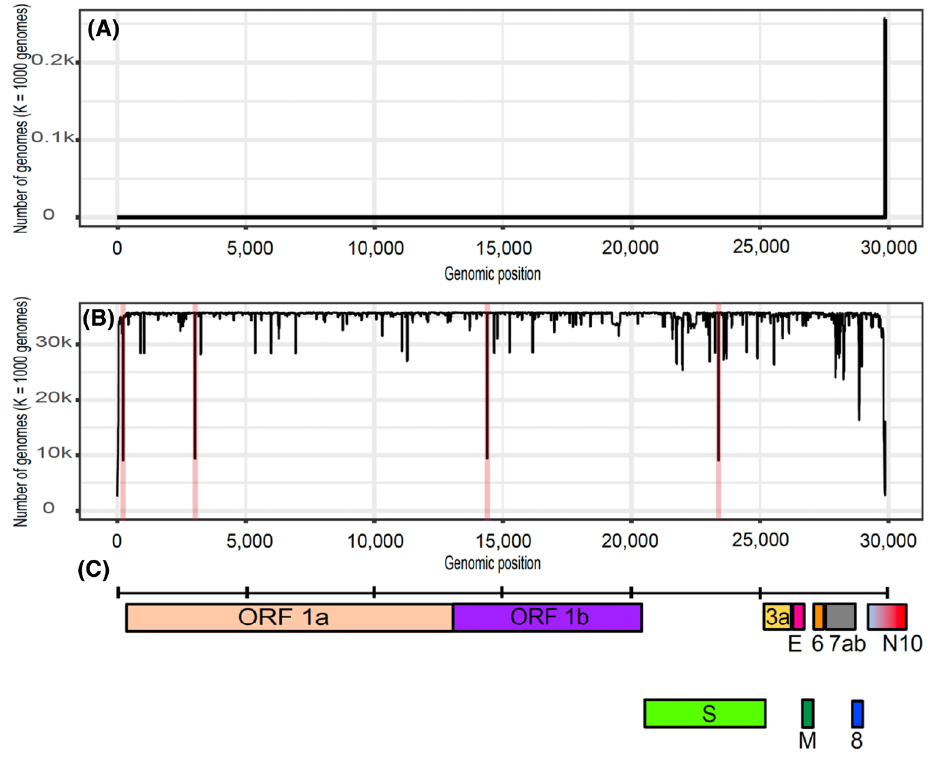
Figure 1. ( A ) Genome-wide environmental conservation landscape. ( B ) Genome-wide population conservation landscape; positions 241, 3037, 14,408 and 23,403 are highlighted in red. In both panels, the X axis represents the genome position and the Y axis represents the number of genomes that contain each reference kmer. ( C ) Genome